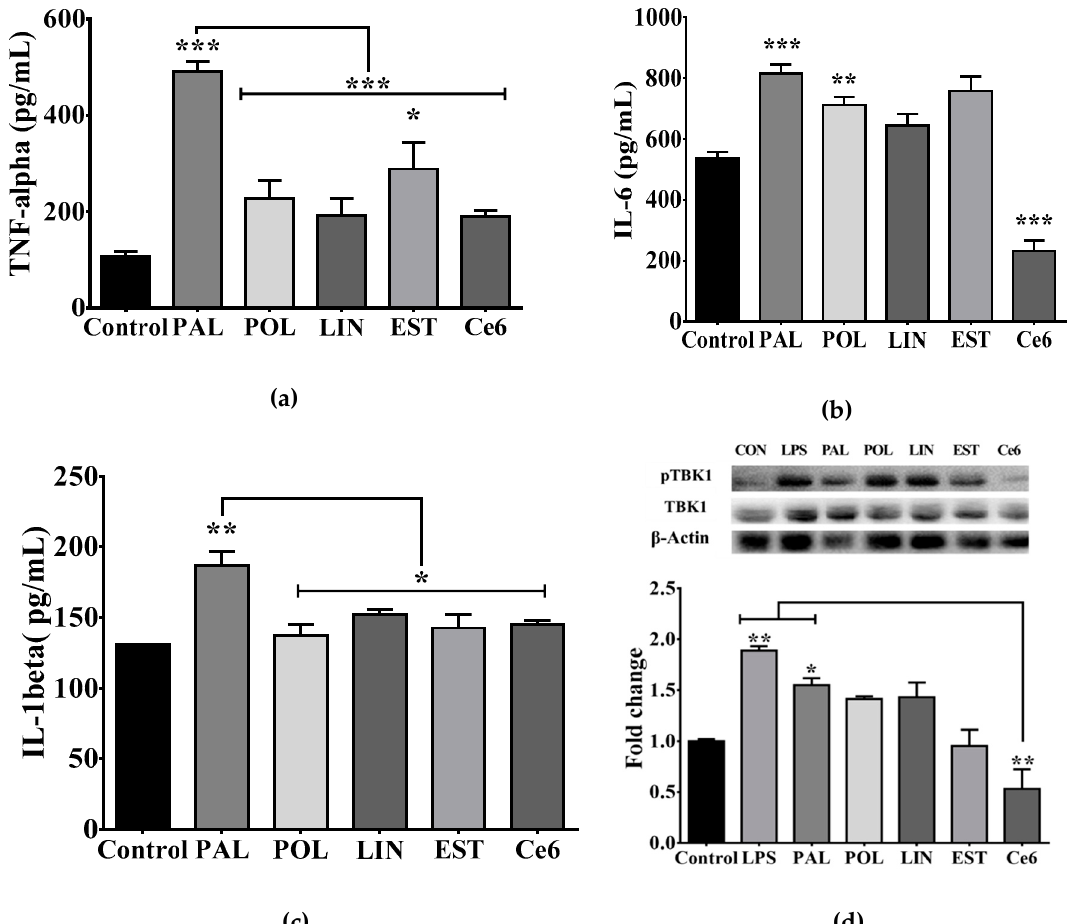
Figure 3. Palmitic acid incubation leads to cytokine production and TBK1 pathway activation in primary microglia. ( a ) TNF-alpha secretion, ( b ) IL-6 secretion or ( c ) IL-1 β secretion by primary microglia culture following 1% BSA-FFA (Control); 100 μ M palmitic acid, palmitoleic acid, linoleic acid or stearic acid or 25 μ M C6 ceramide incubation for 24h. TNF-alpha, IL-6 and IL-1 β secretion were quantified by ELISA following the manufacturer’s instructions ( n = 4). ( d ) TBK1 phosphorylation following saturated and unsaturated fatty acids stimulation was identified using western blot analysis. The graphs show normalized data of the mean ± S.E.M. Two-way ANOVA followed by Tukey multiple comparation test; * p < 0.05, ** p < 0.01, *** p < 0.001). TBK1, TANK-binding kinase 1, BSA-FFA, Bovine serum albumin-free fatty acids (FFA).